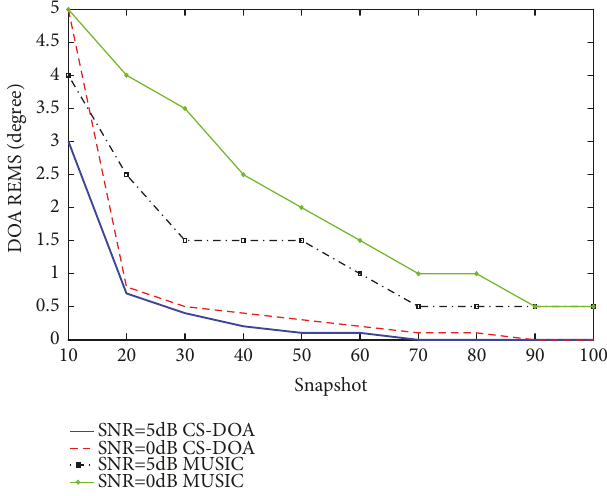
Figure 5: DOA RAMES versus